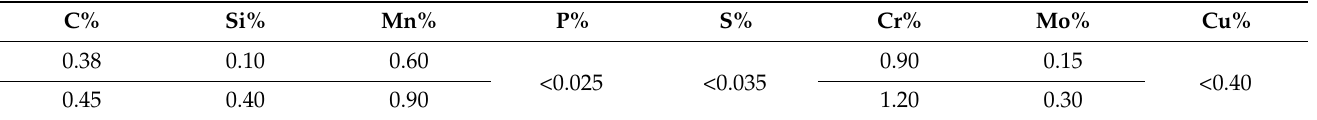
Table 3. Chemical composition of 42CrMo4